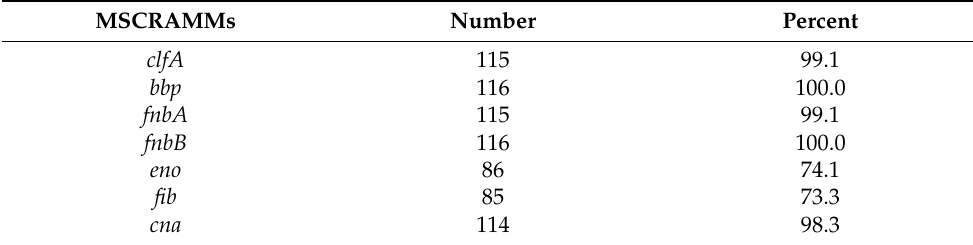
Table 5. MSCRAMMs positivity rate in S. aureus